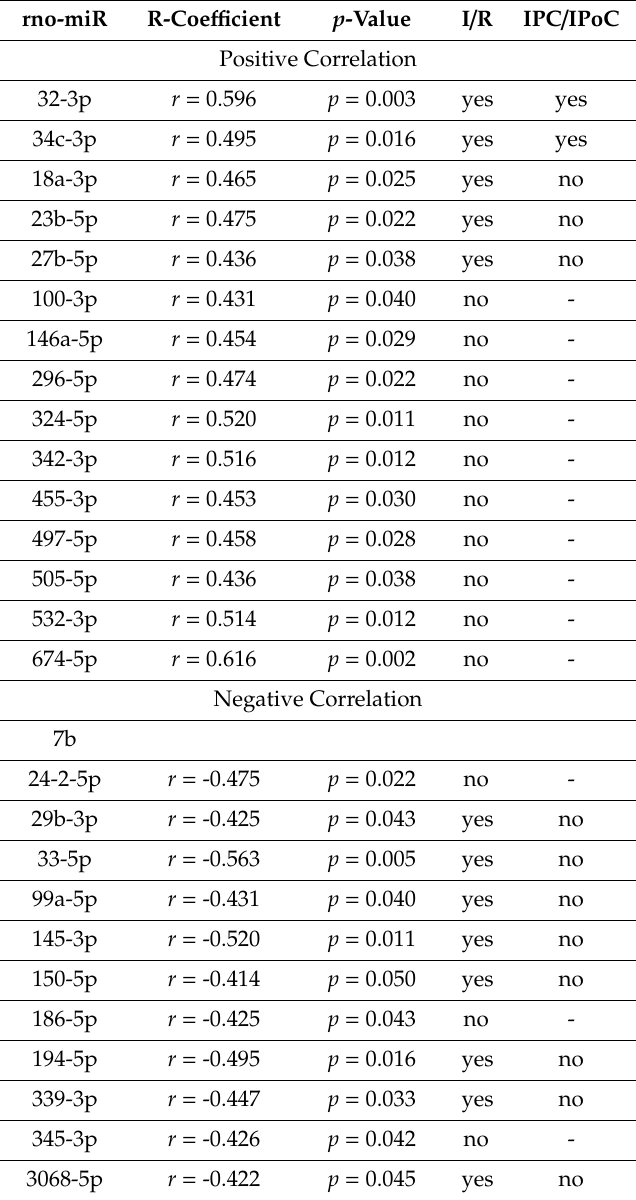
Table 1. Correlation between swiprosin-1 mRNA and micro-RNAs